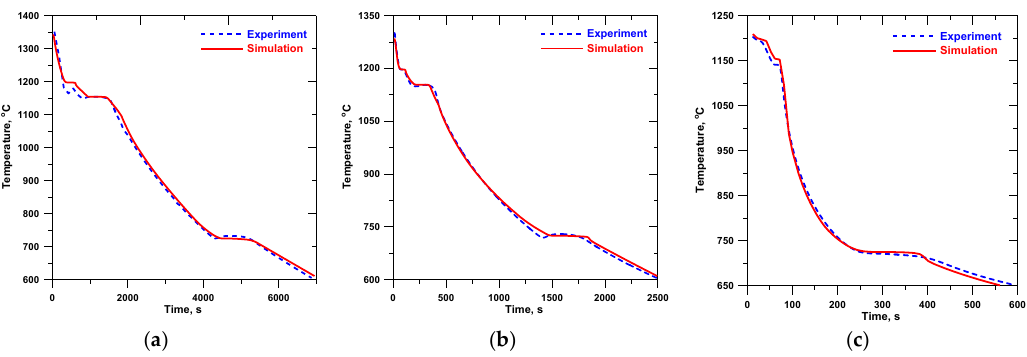
Figure 7. Simulated and experimental cooling curves (central thermocouple) for alloy B: ( a ) insulation, ( b ) sand, and ( c ) chill.